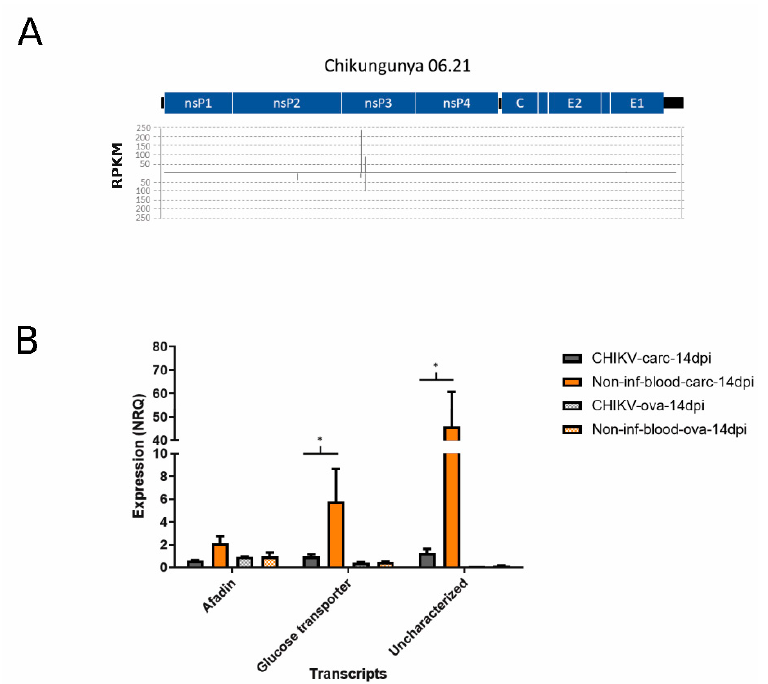
Figure 3. ( A ) Graphical representation of the hotspots on the viral genome for small RNA molecules that map to both CHIKV and Ae. albopictus transcripts. ( B ) Bar plot of the qPCR results on three candidate target transcripts of viral small RNA molecules: afadin (XM_029860564.1), glucose- transporter (XM_029879742.1), and uncharacterized transcript (XM_029866737.1). ANOVA significant results at p < 0.05 are indicated by an asterisk.